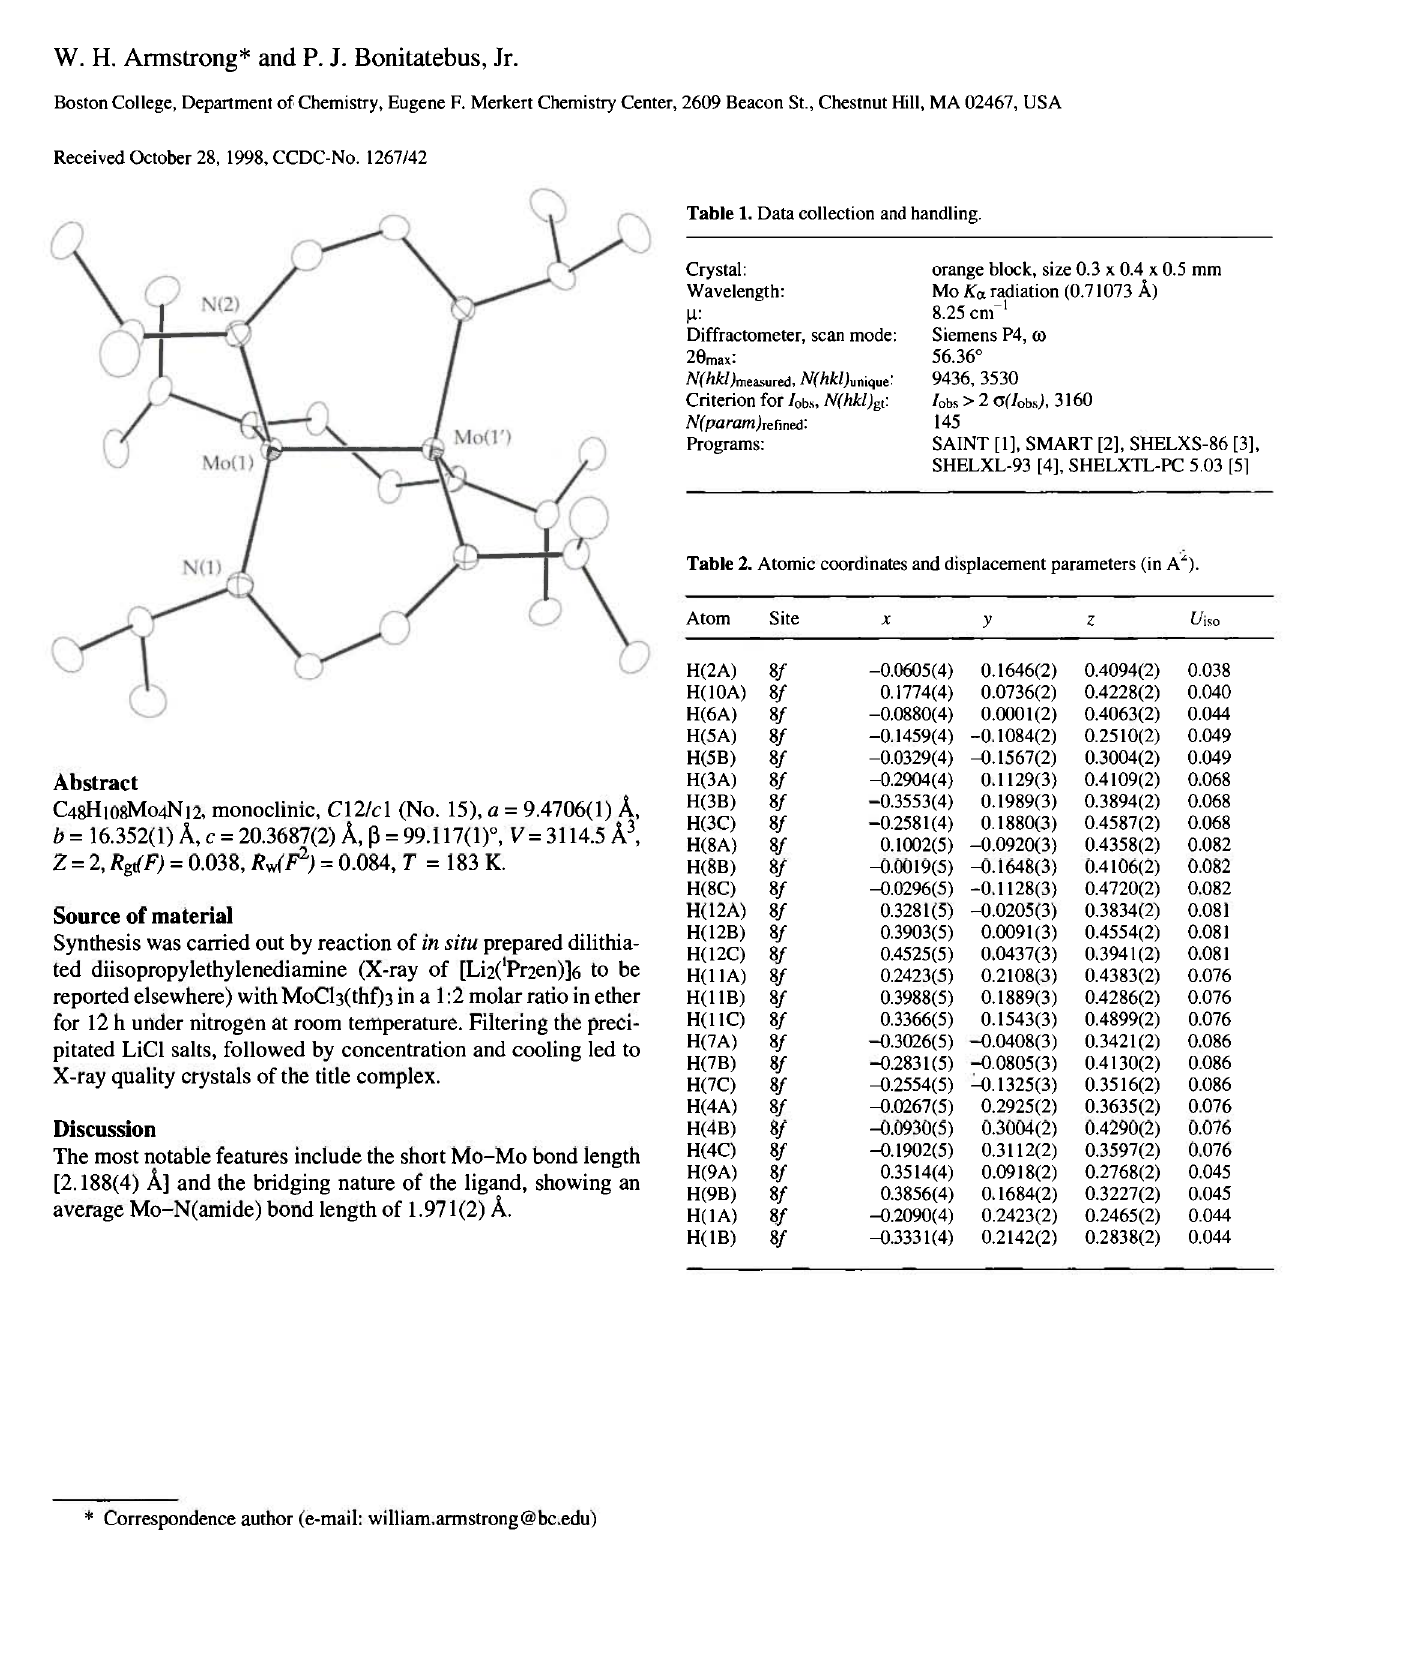
Table 1. Data collection and handling.